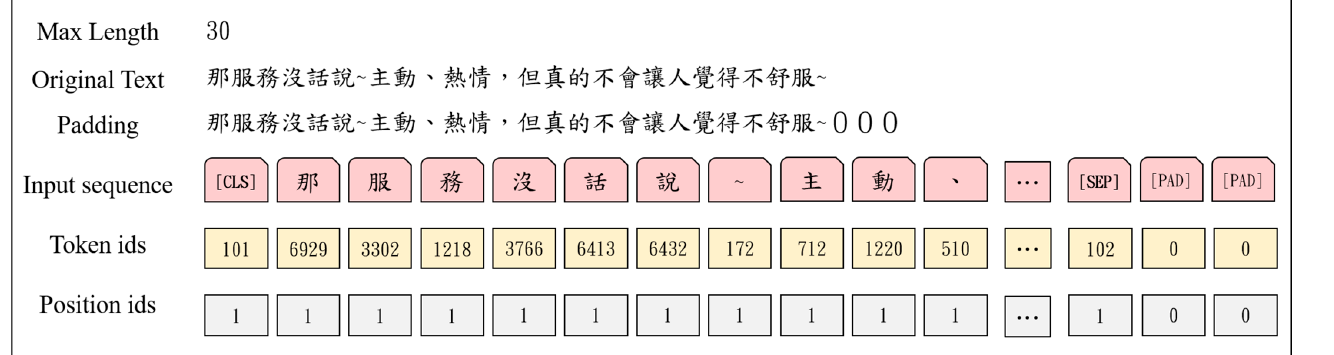
Figure 5. Example conversion process of the token and position IDs. Note: The translation of the sentence in the example is “ 那服務沒話說 ~ ([I have] no negative comments about that service at all) 主動 (proactive), 熱情 (enthusiastic), 但真的不會讓人覺得不舒服 ~ (But [it] really won’t make you feel uncomfortable)”.